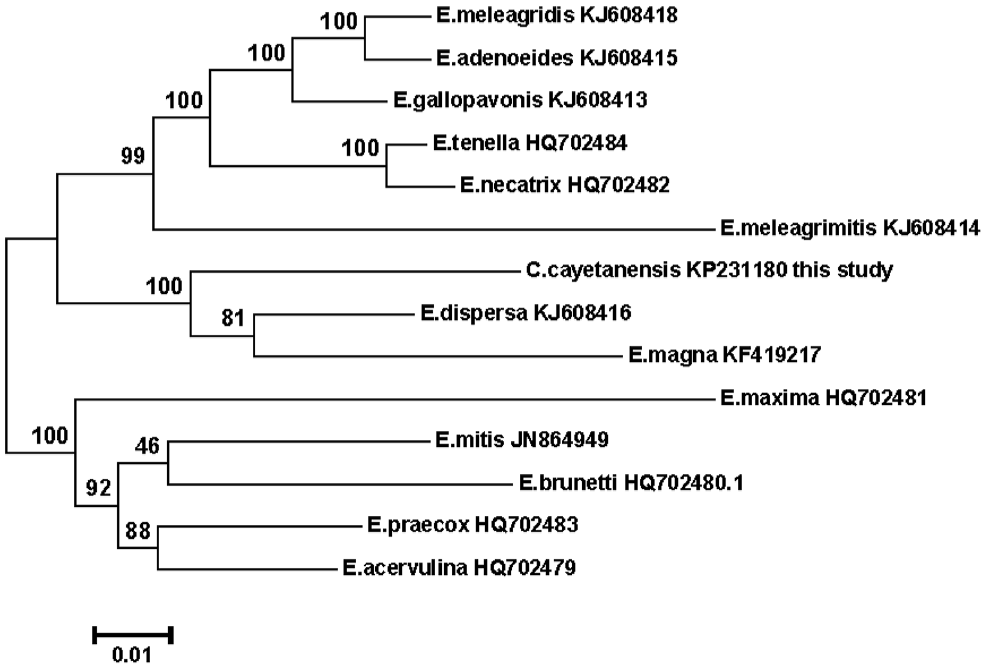
Fig 3. Phylogenetic relationships among Eimeria species and C . cayetanensis based on mitochondrial genome sequences. NCBI accession numbers are included. The evolutionary relationship between the Eimeria (13), Cyclospora(1) and P . falciparum (1) mitochondrial genomes was inferred using the Maximum Likelihood method with 500 replications for bootstrap analysis. The confidence value for clustering is given as percentage above the branches. The scale bar points to the number of substitutions per site. After analysis, the outgroup branch was removed for clarity. Default parameters in MEGA6 were retained for phylogenetic analysis and tree